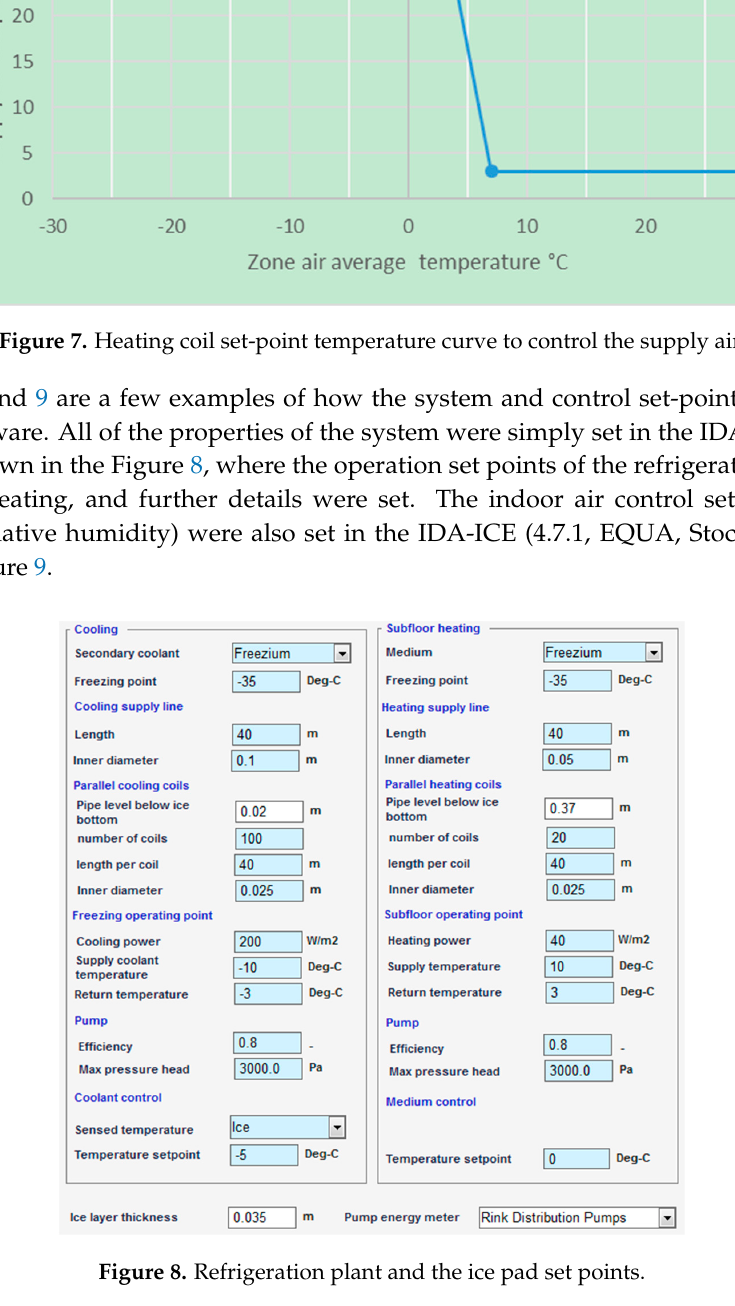
Figure 8. Refrigeration plant and the ice pad set points.